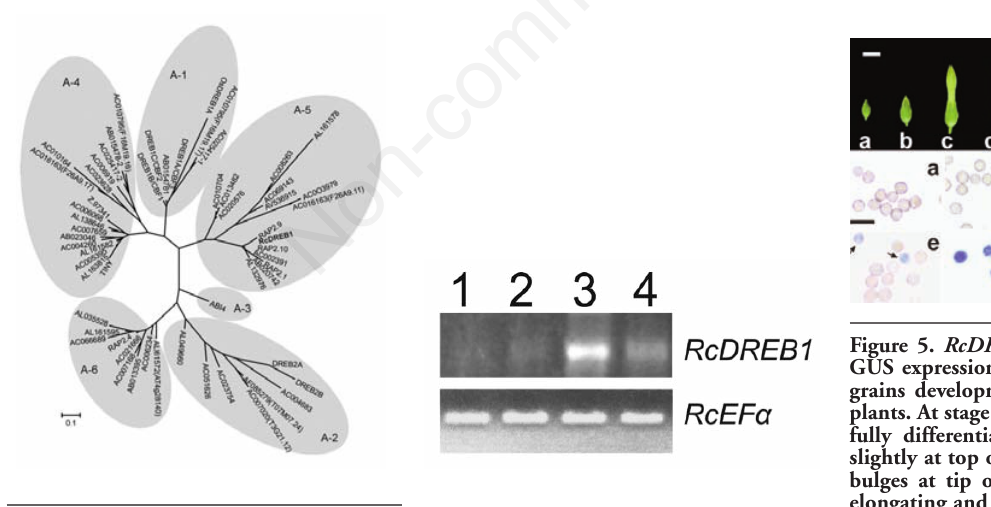
Figure 3. Phylogenetic analysis of RcDREB1 with other DREB proteins. The RcDREB1 grouped with the A-5 subgroup. The amino acid sequences were aligned by Clustal W and the phylogenetic tree was constructed using MEGA 5.0 and the Neighbor-Joining method. The tree includes AP2 domains available in GenBank and TIGR databases. Cut-off bootstrap values >50% were considered for the consensus tree.